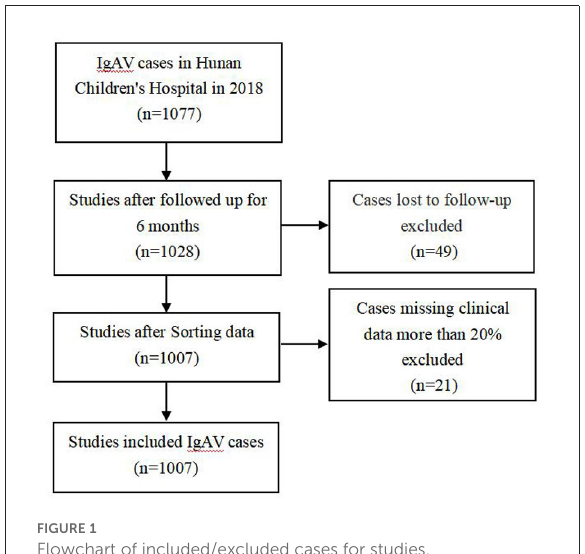
FIGURE1 Flowchart of included/excluded cases for studies.